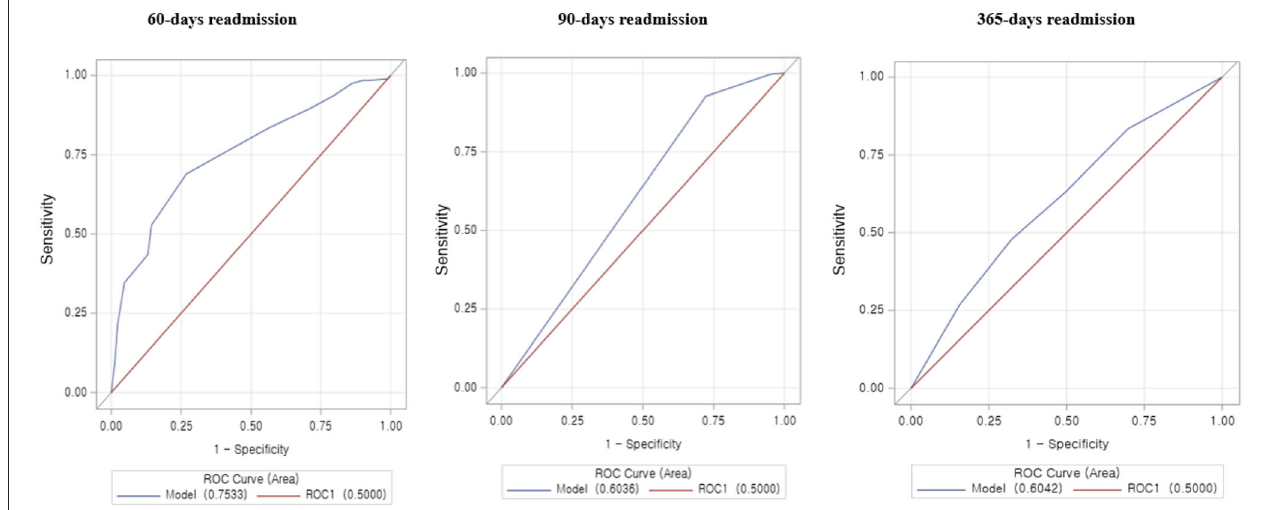
FIGURE 4 | An area under the receiver operator curve (ROC) for the LACE index predict 30-day readmission in hospitalized patients with AMI. The ROC curve illustrates the risk prediction for 60, 90, and 365 days (1 year) readmission at different cutoff